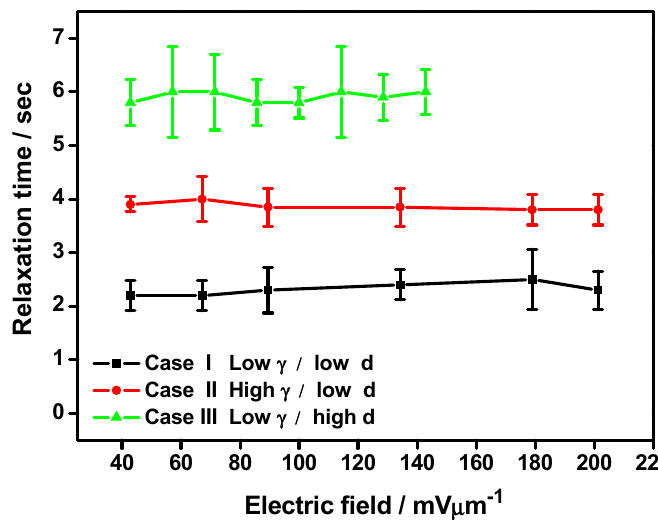
Figure 5. The relationship of the averaged relaxation time of representative GP flakes with different NLC host-types and cell thicknesses after removing the electric field (Case I: low γ , low d ; Case II: high γ , low d ; and Case III: low γ , high d ). The scattered points represent the experimental data along with the measurement error bars, and the lines are guides for the eye. Error bars for respective data points are assigned considering the standard deviations obtained in repetitive observations.